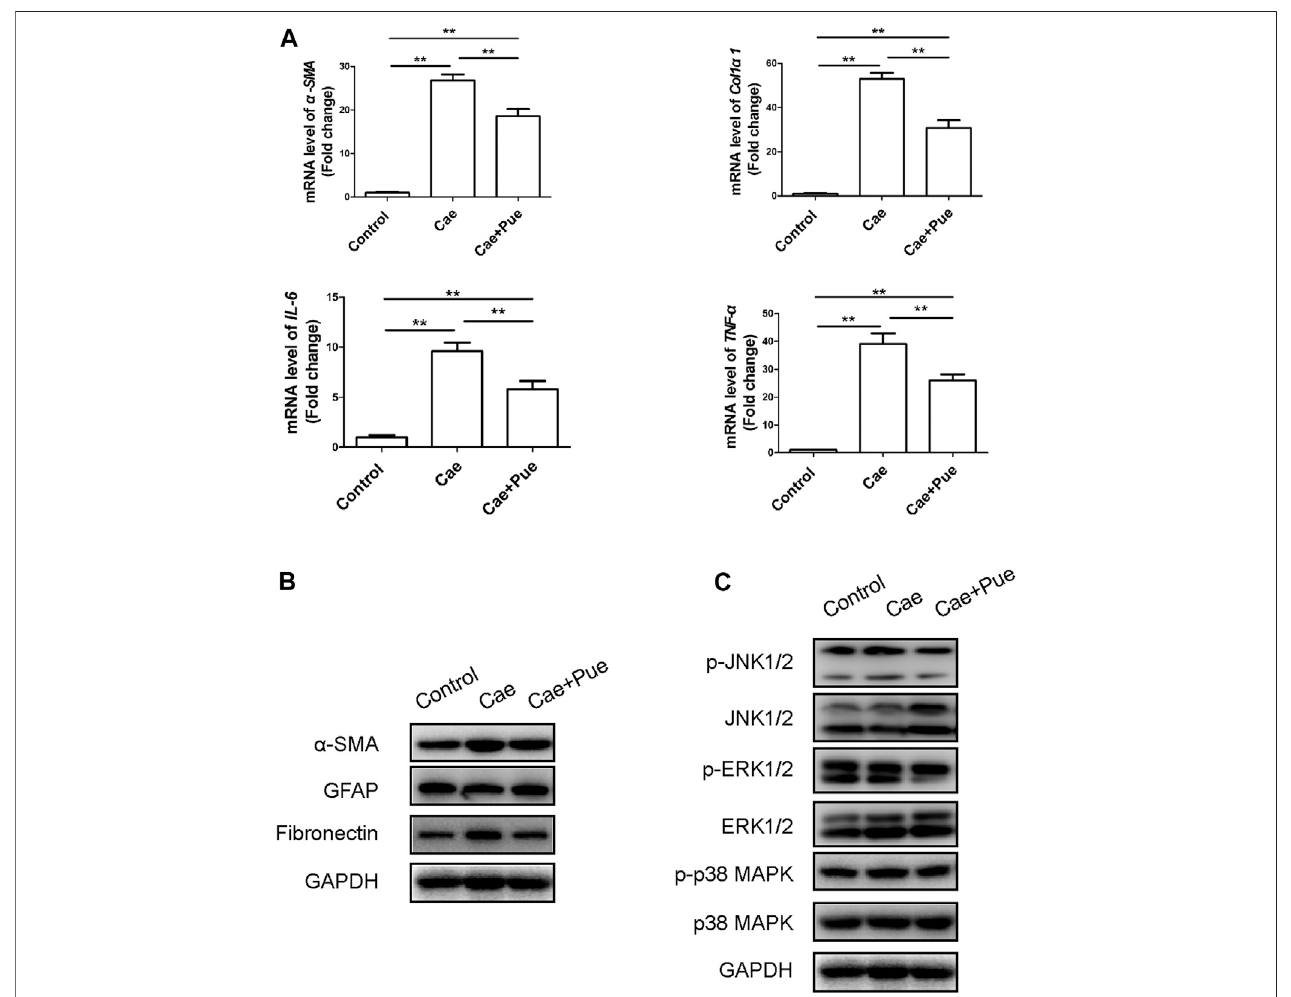
FIGURE 3 | Puerarin ameliorated pancreatic in fl ammation and fi brosis in vivo maybe through inhibiting the phosphorylation activation of MAPK family proteins. (A) Expression of fi brotic and in fl ammatory associated genes ( α -SMA, Col1 α 1, TNF- α and IL-6) of pancreatic tissues were quanti fi ed by qRT-PCR and compared among three groups. Data were presented as mean ± SD of at least three independent experiments. * p < 0.05, ** p < 0.01. (B) The protein expression levels of fi brotic and in fl ammatoryassociatedgenes( α -SMA,GFAPandFibronectin)ofpancreatictissuesweretestedbyWesternblottinganalysisandcomparedamongthreegroups. (C) The total proteins and phosphorylation proteins expression levels of MAPK family proteins (including JNK1/2, ERK1/2 and p38 MAPK) of pancreatic tissues were tested by Western blotting analysis and compared among three groups.